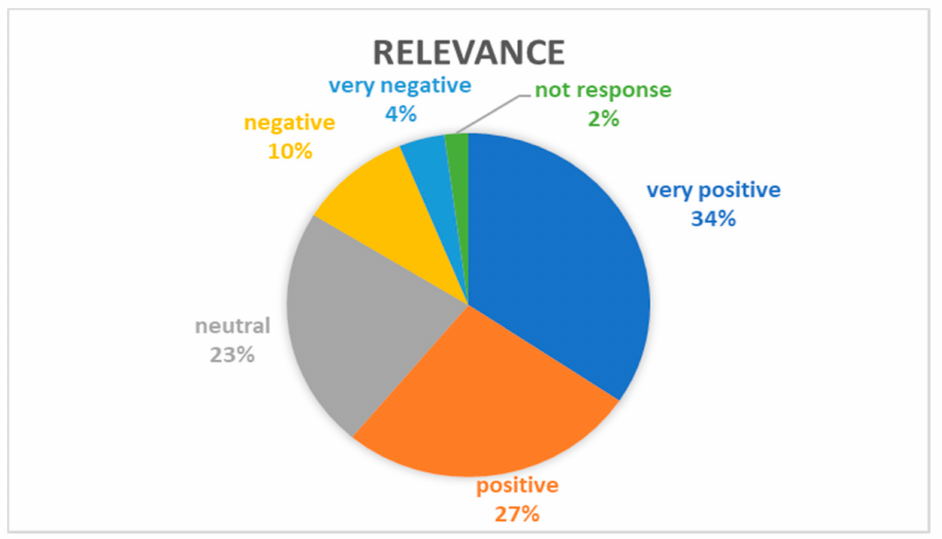
Figure 4. Graph of the average response to the questions of the relevance dimension.